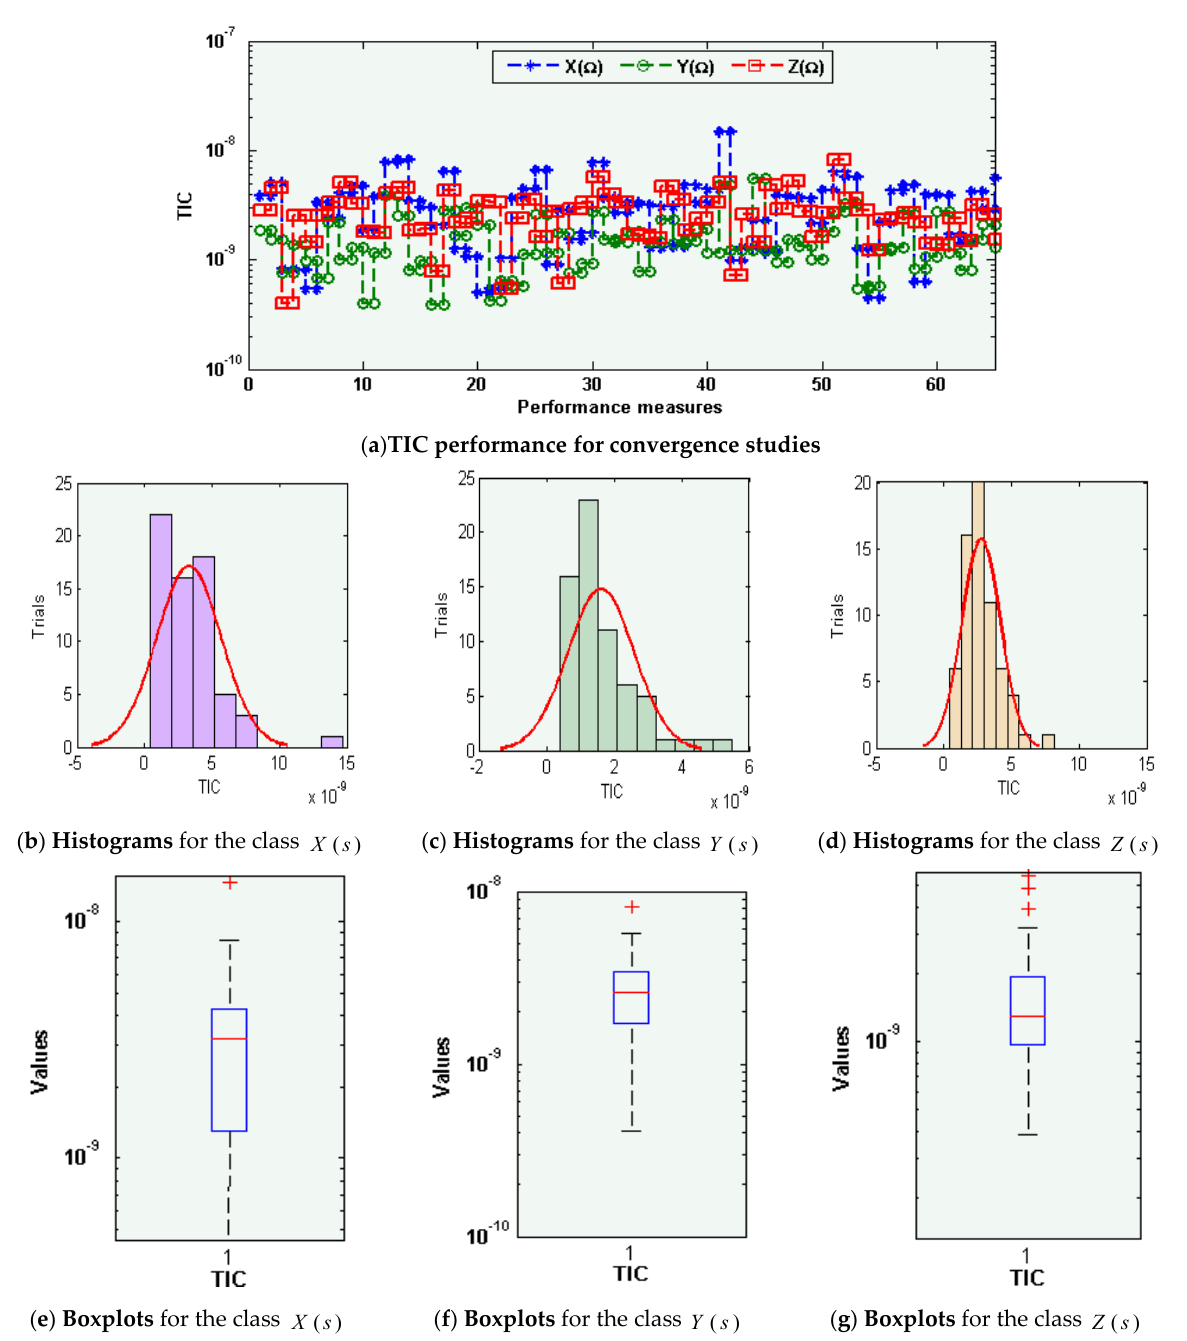
Figure 5. TIC operator performances based on ANN-GA-IPA to solve the environmental and economic nonlinear model.